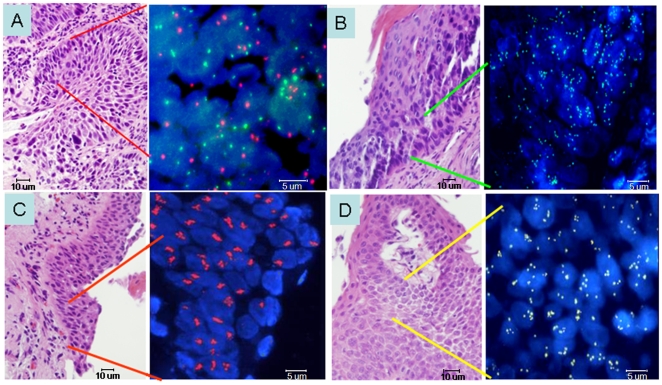
Dual color fluorescence in situ hybridization of TP63 gene (3q28, green spots) and a CEP3 probe (red spots) on the centromeric region of the same chromosome on a carcinoma in situ (CIS) of the lung.Interphase nuclei stained in blue with DAPI show increased copy number of TP63 in CIS (A). Segmented images of 4-color hybridization assays with the LAVysion probe in severe dysplasia lesions, showing high copy numbers of the 5p15.2 genomic region (green spots) (B); EGFR gene amplification (clustered red spots) (C); and high copy numbers of MYC (yellow spots) (D). All sections analyzed by FISH were sequential to the H&E section presented.